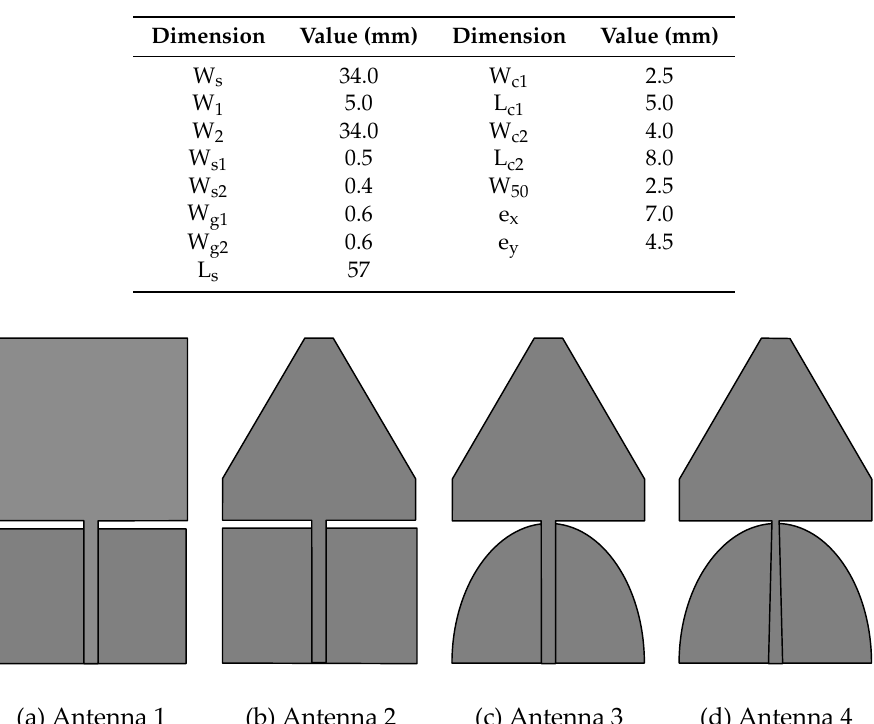
Table 1. The dimension of the proposed tri-notch characteristics SWB antenna.